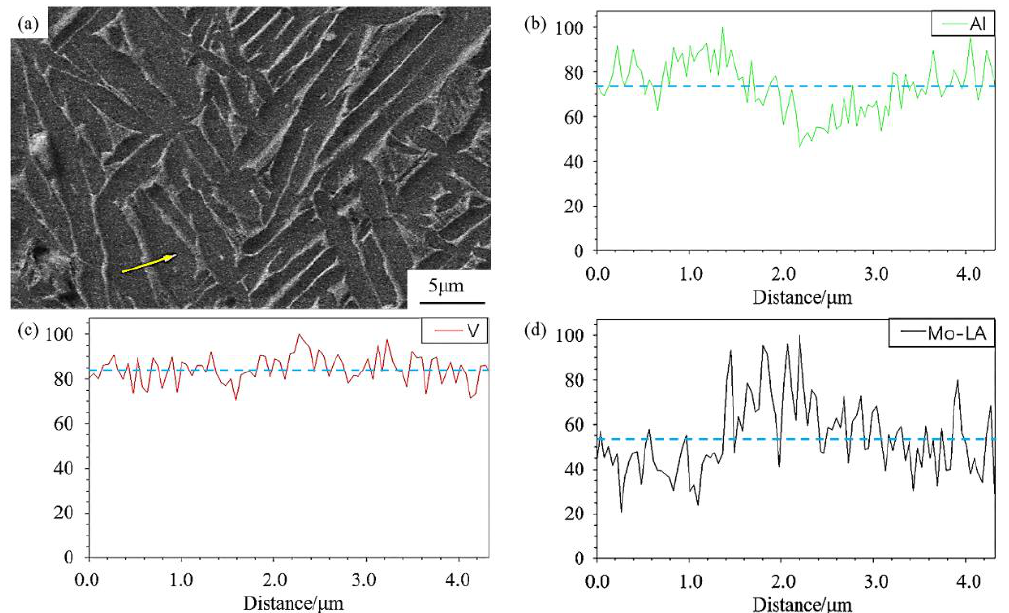
Figure 6. The EDS element line scan in the material heat-treated at 900 °C /2 h/AC: ( a ) SEM images of the annealed α + β microstructure, where the yellow arrow represent the EDS line scan location. ( b – d ) EDS line scan of Al, V and Mo.